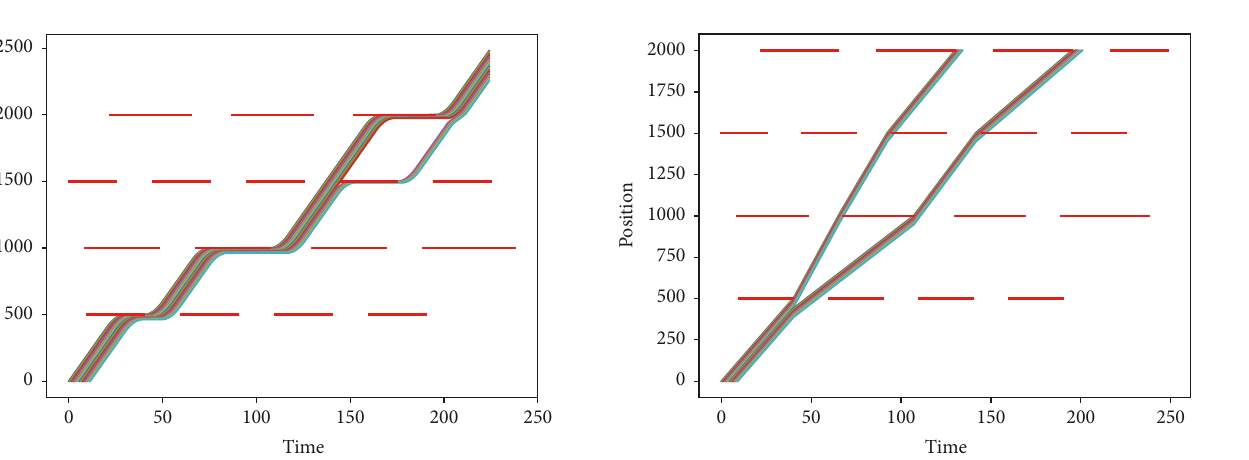
Figure 7: Trajectory of vehicles of platoon without separation strategy.